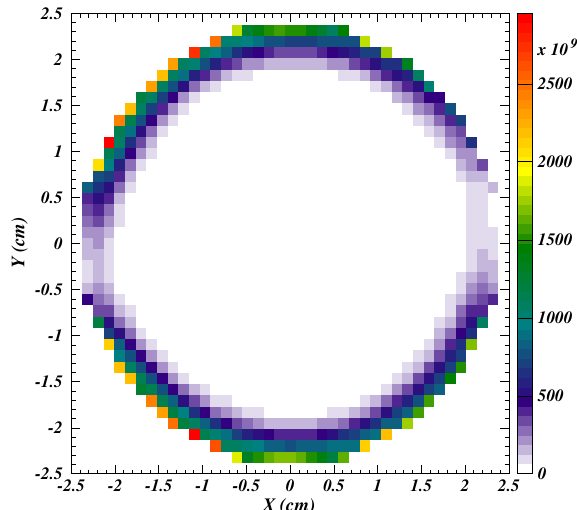
FIG. 14. Effect of a 40-G solenoidal magnetic field on the simulated EC density profile in a fieldfree region of the